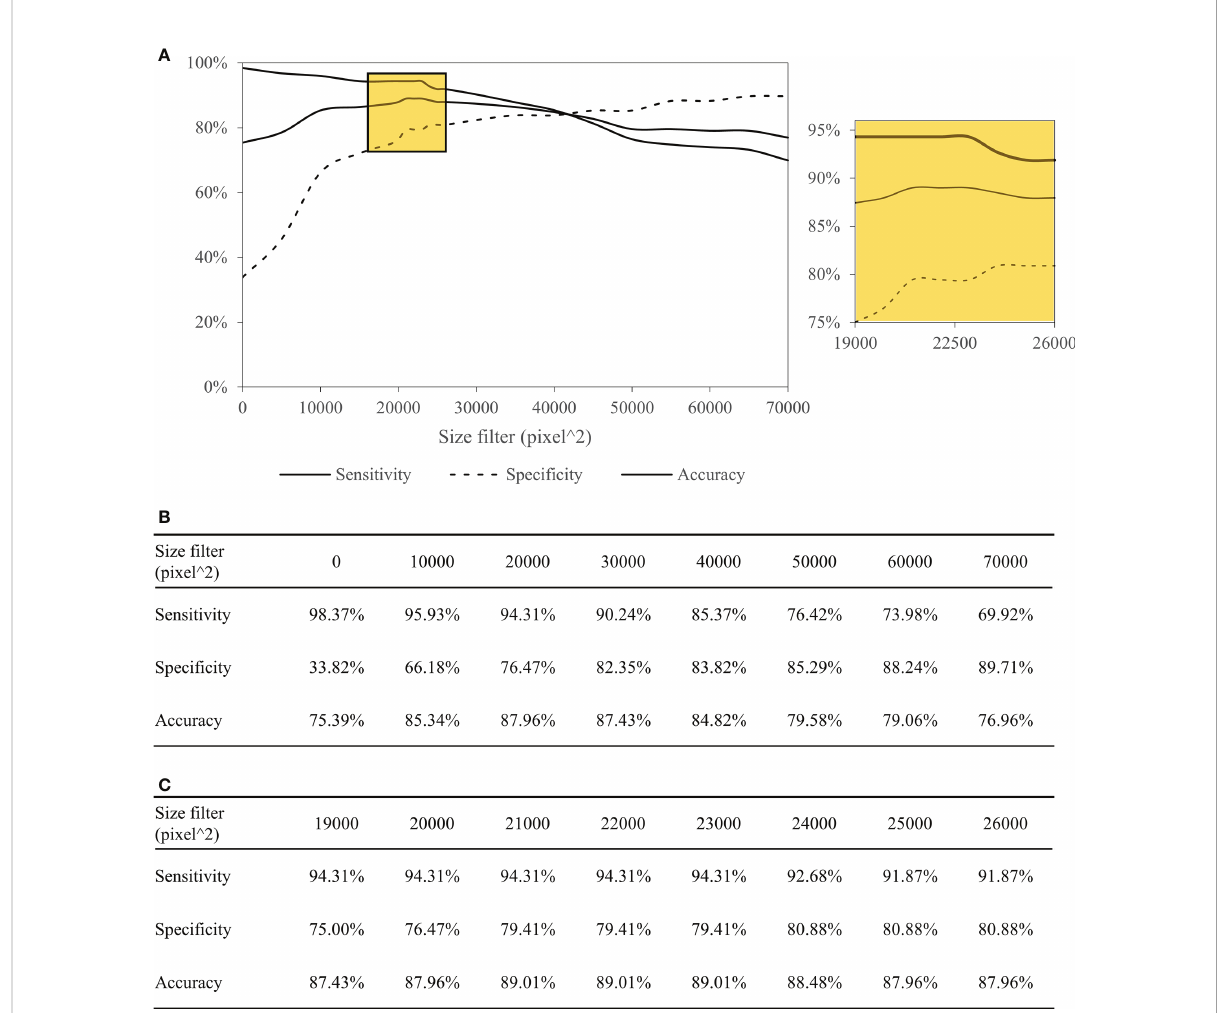
FIGURE 5 Performance of the Domain-KEY algorithm following the application of various size fi lters with different cutoffs. Curves depicting the diagnostic performance (A) as well as sensitivity, speci fi city, and accuracy (B, C) of the Domain-KEY algorithm following the application of various size fi lters with different cutoffs. The cutoff values started from 0 pixel^2 and were increased in stepwise fashion using an interval of 10,000. The accuracy for the detection of PNI improved by 9.95% when the cutoff increased from 0 to 10,000 pixel^2, with an optimal diagnostic performance (>87%) in the 20,000 − 30,000 pixel^2 range. When the cutoff was restricted to a 21,000 − 23,000 pixel^2 range, an accuracy >89% was achieved. When cutoff values >30,000 pixel^2 were tested, the accuracy decreased and subsequently fell to values similar to those observed when a cutoff of 0 pixel^2 was